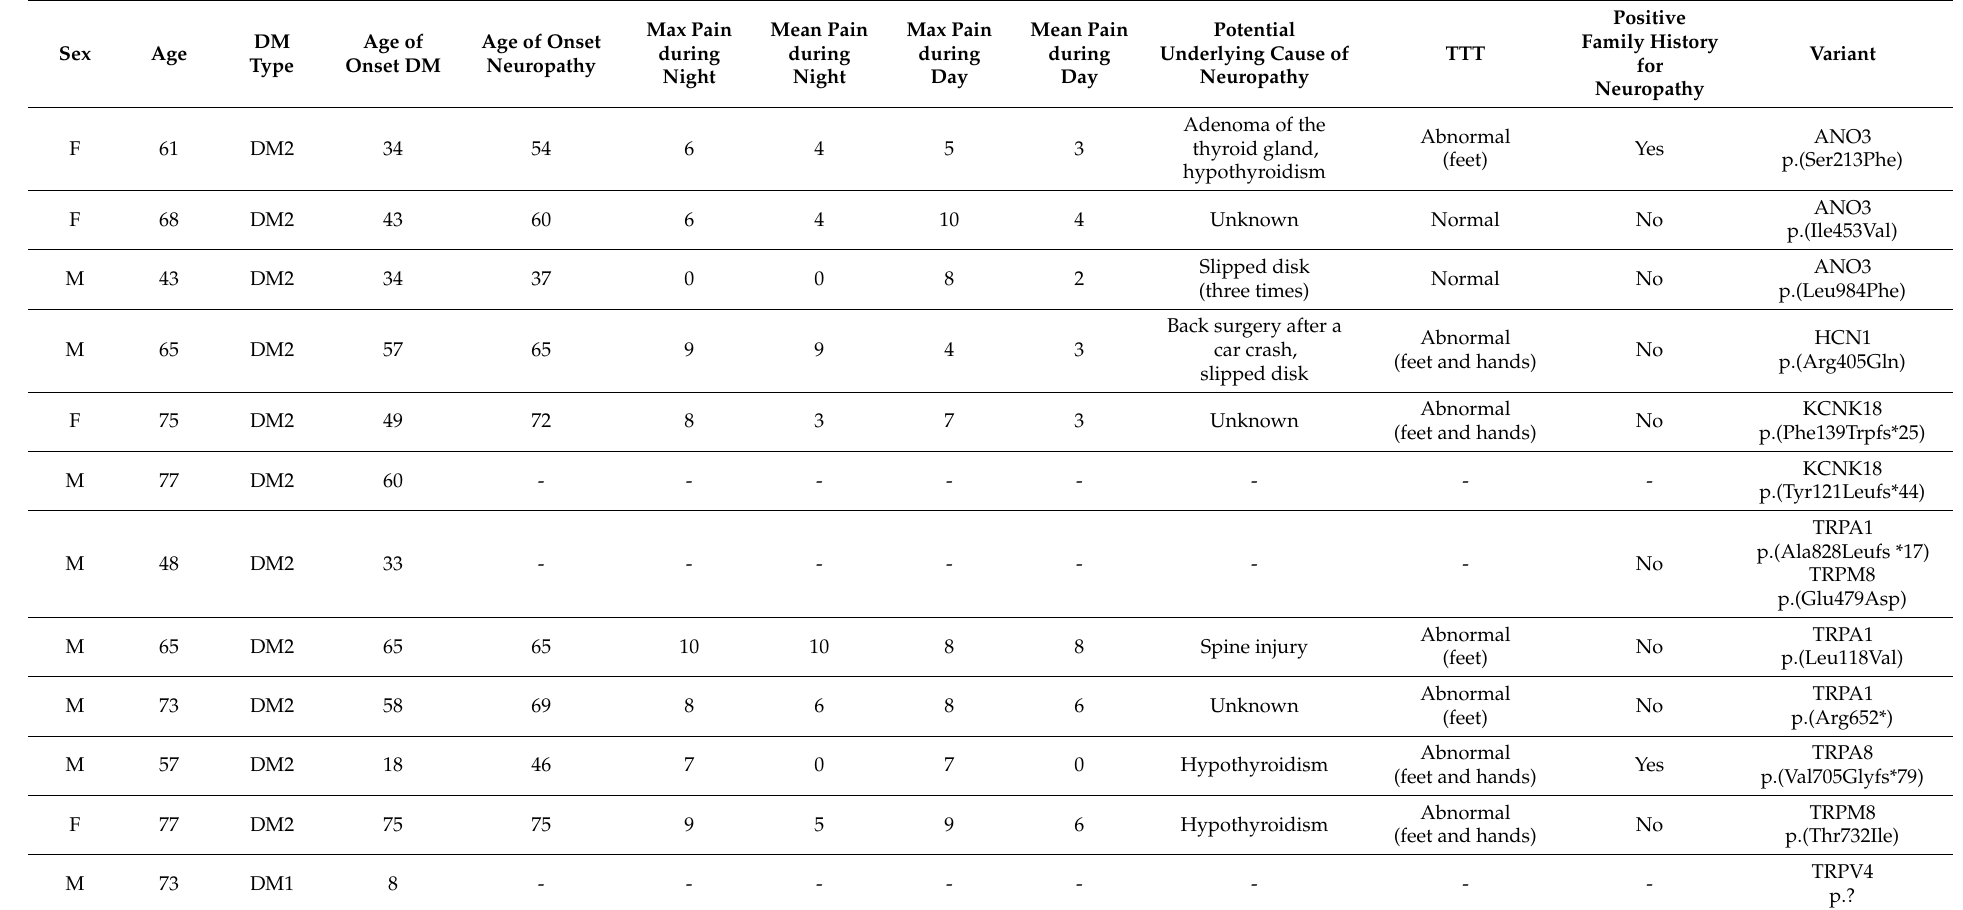
Table 2. Clinical characteristic of patients with painful-diabetic neuropathy and ion channel gene